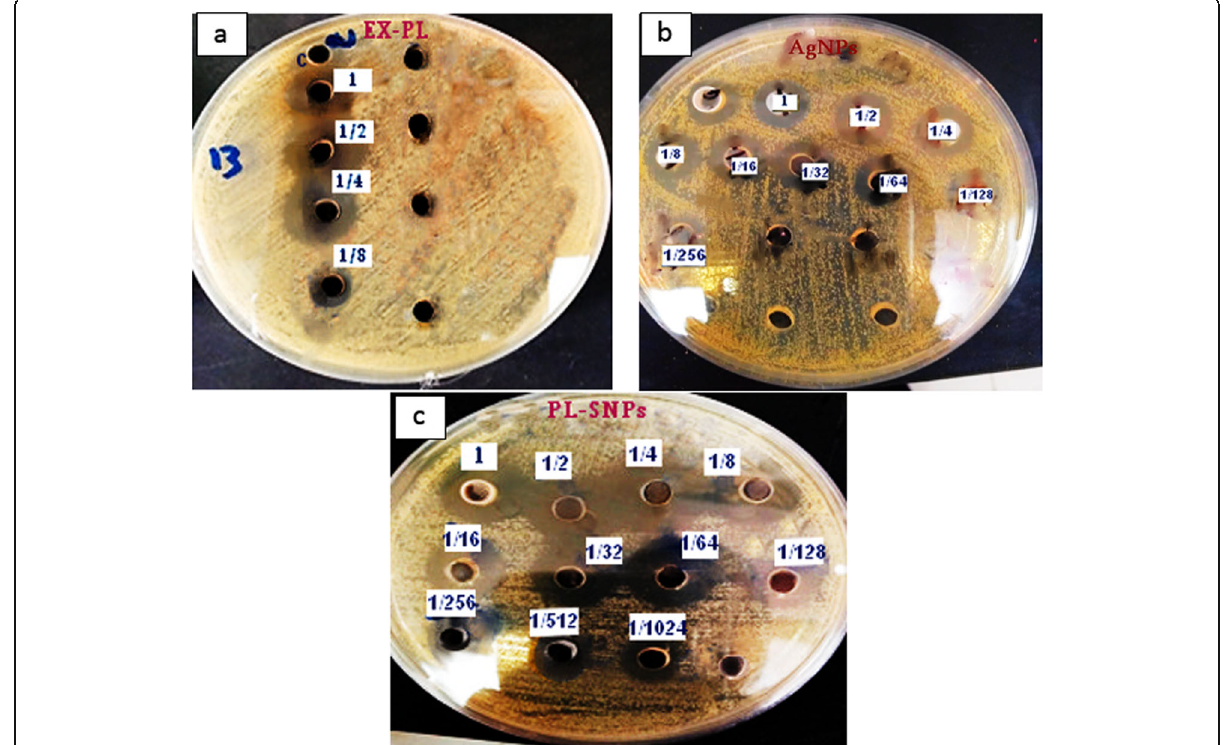
Fig. 7 The arbitrary unit detection of bacteriocin using well diffusion method, against S. aureus . a Extracted bacteriocin EX-PL. b Free AgNPs solution. c Plantaricin-incorporated silver nanoparticles